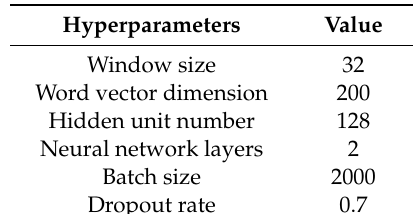
Table 5. Hyperparameter settings.